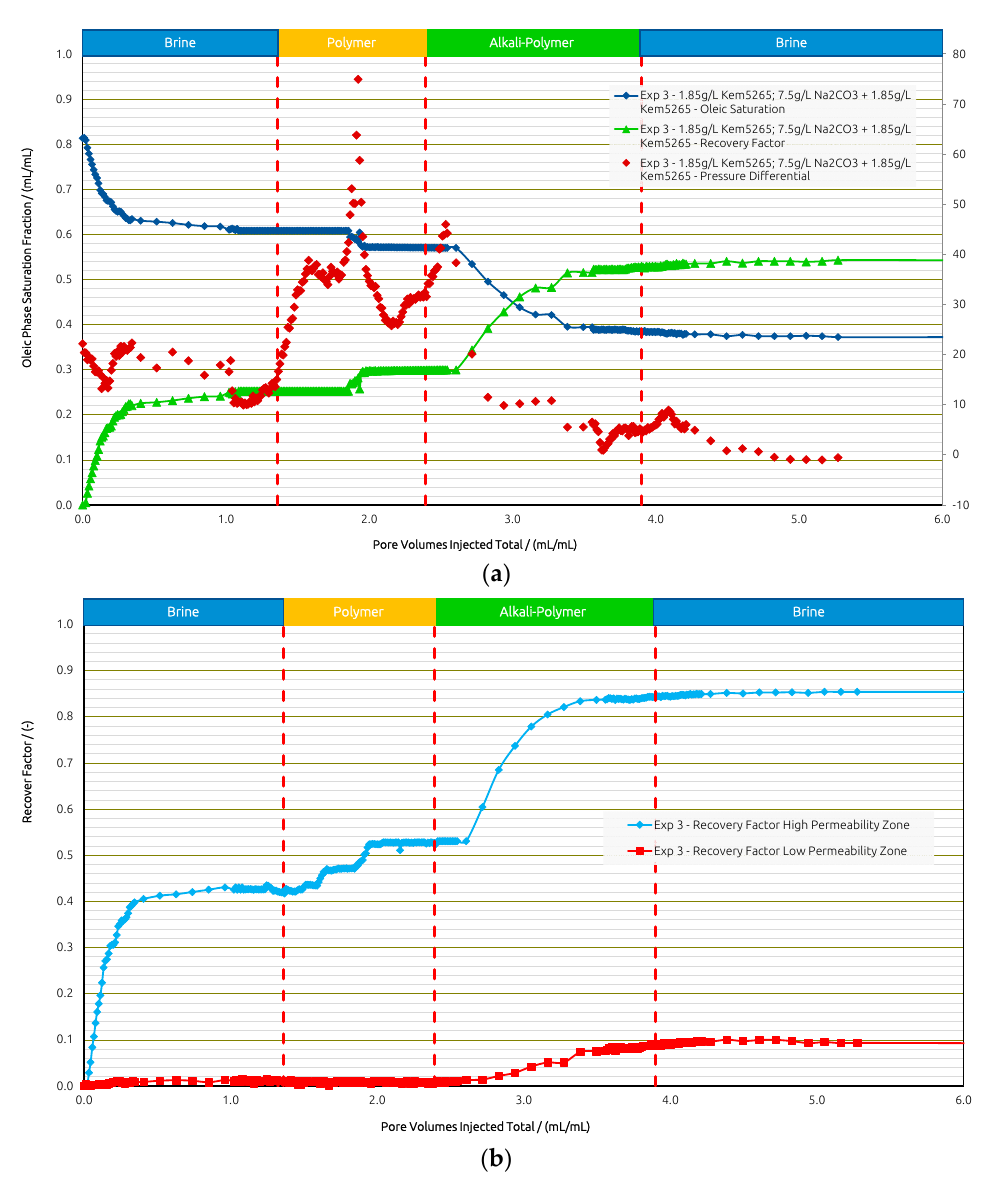
Figure 12. Summary of results obtained for Exp. 3 in micromodel experiments. ( a ) Oleic saturation, Recovery Factor (RF), and pressure differential for the entire chip and ( b ) RF of low-permeability zone vs. RF of high-permeability zone.